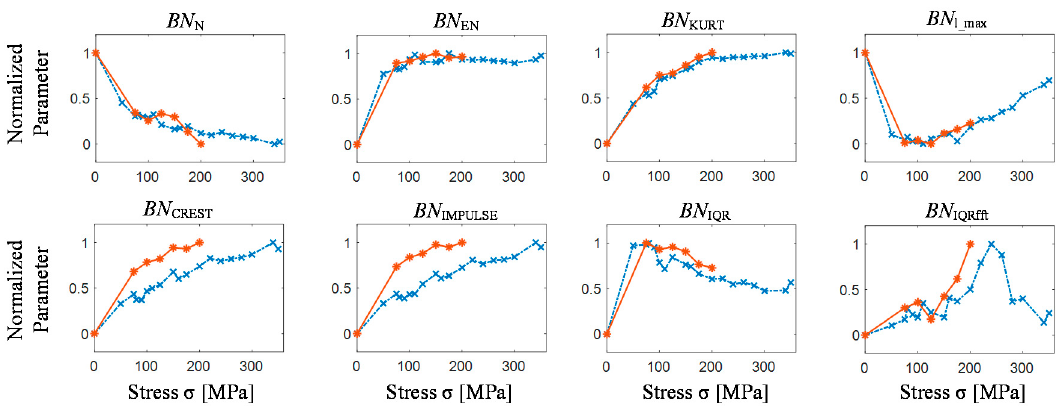
Figure 12. Features distribution extracted from T and F domain representation of BN signal for successive stress-strain stages; sample s 1 results—red line; sample s 2 results—blue line.